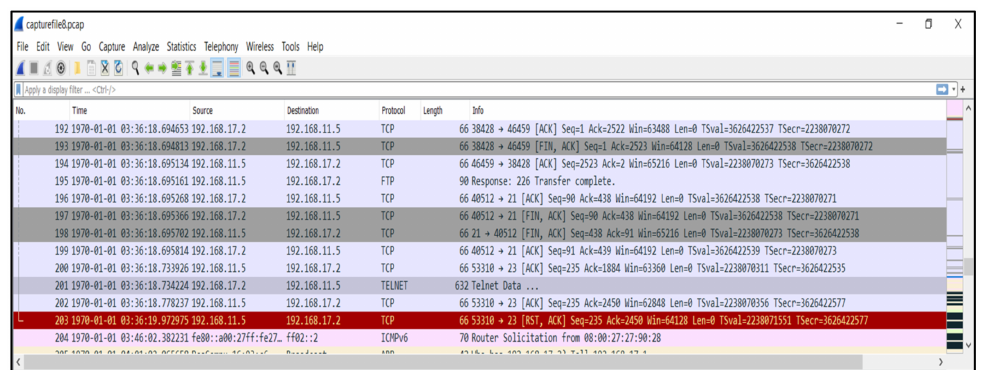
Figure 7. Utilisation of Wireshark to analyse the pcap files and follow the network